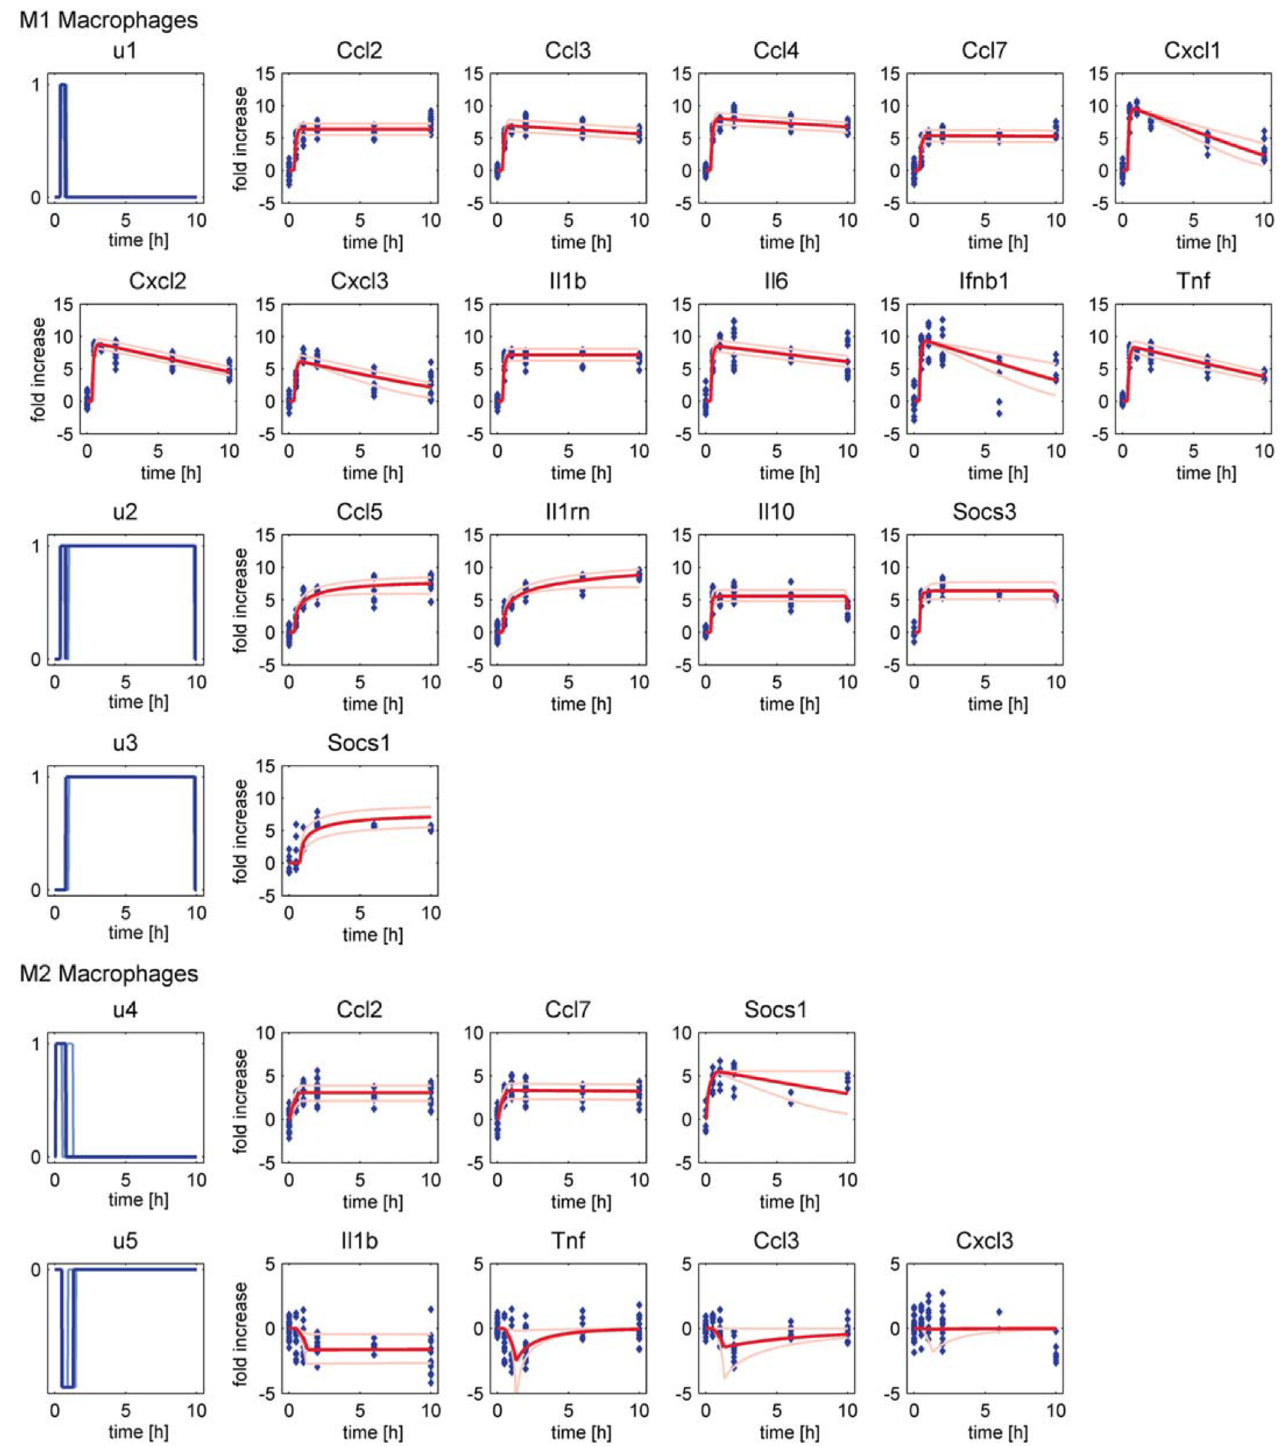
Fig 5. Simulation results of the ODE model describing mRNA expression in LPS- and IL-4/13-stimulated macrophages. Best fit of mRNA expression in LPS-stimulated M1 and IL-4/13-stimulated M2 macrophages is displayed as dark red line with the measurement points displayed as blue diamonds. The input functions u are displayed in the first column in dark blue and represent the regulation motifs: ( u 1 ) regulated by NF- κ B, ( u 2 ) regulated by NF- κ B and Stat3, ( u 3 ) regulated by Stat3, ( u 4 ) positively regulated after IL-4/13 stimulation by Stat6, and ( u 5 ) negatively regulated in response to IL-4/13. Bounds of the profile likelihood-based 68% confidence intervals are displayed in bright blue and red for input functions and mRNA expression, respectively.